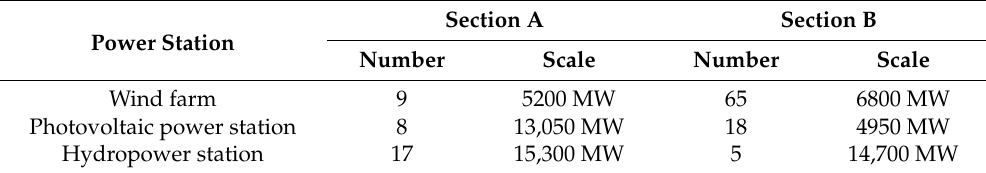
Table 1. The planned distribution of installed capacity of power stations in the Yalong River Wind-PV-Hydro complementary clean energy base. Section A Section B Power Station